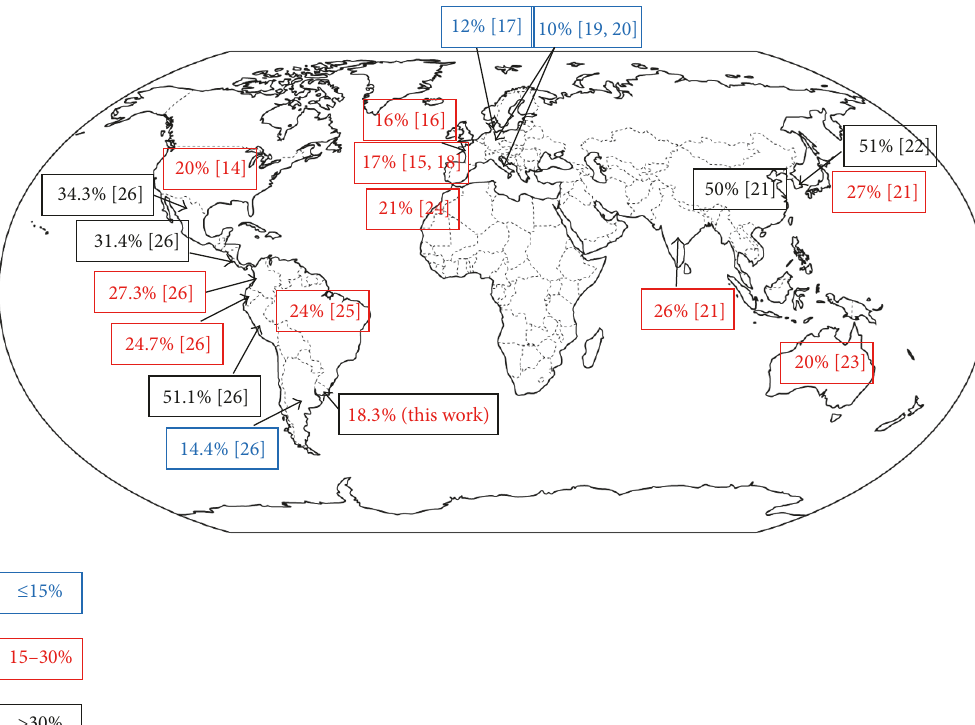
Figure 3: Worldwide distribution of EGFR